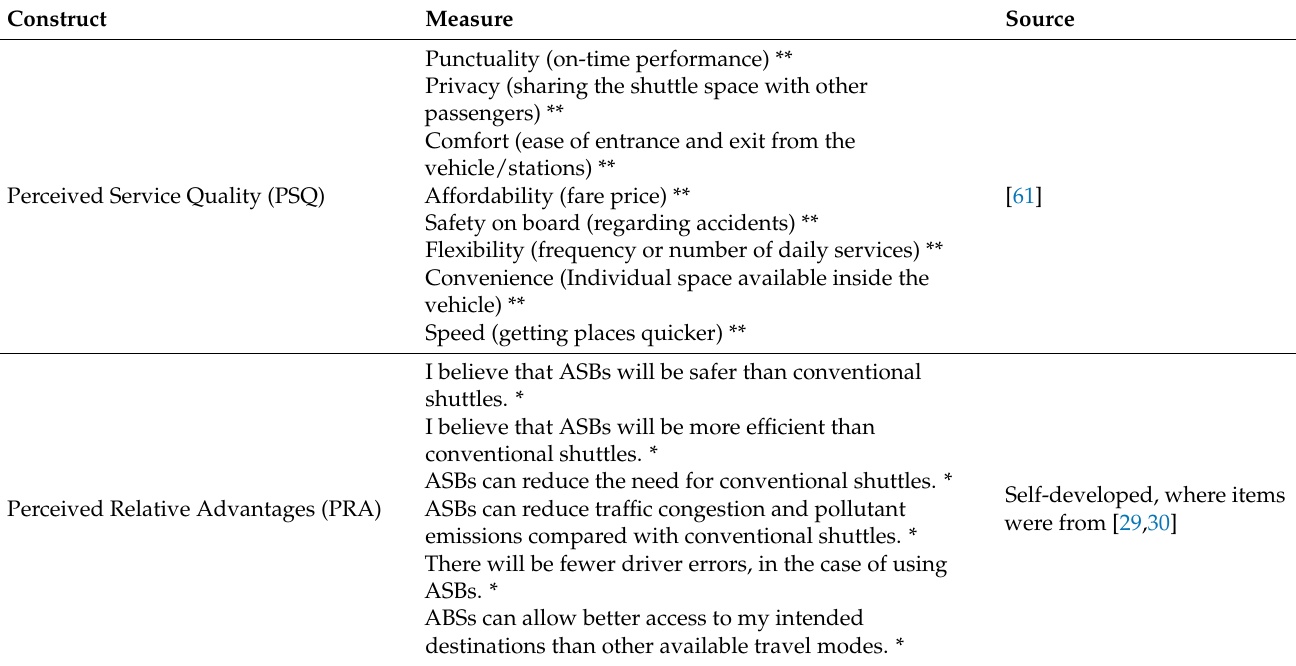
Table 2. Research framework constructs with measurement